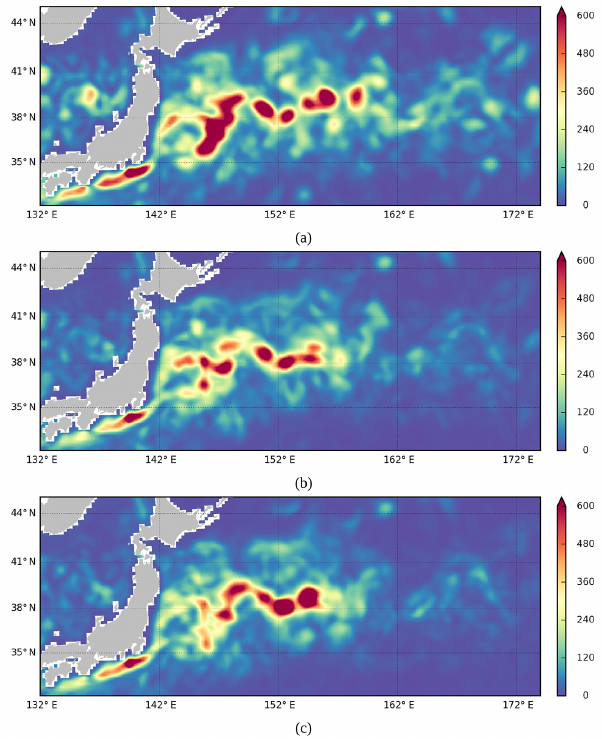
Figure 9. KU analyses MSE of SL in cm 2 for Sat1 (a) , Sat2 (b) and Sat3 (c)